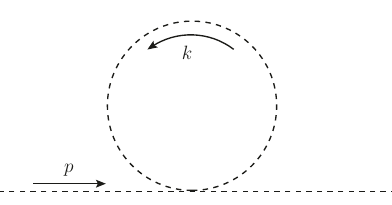
Figure 1. One-loop self-energy for the scalar induced by its